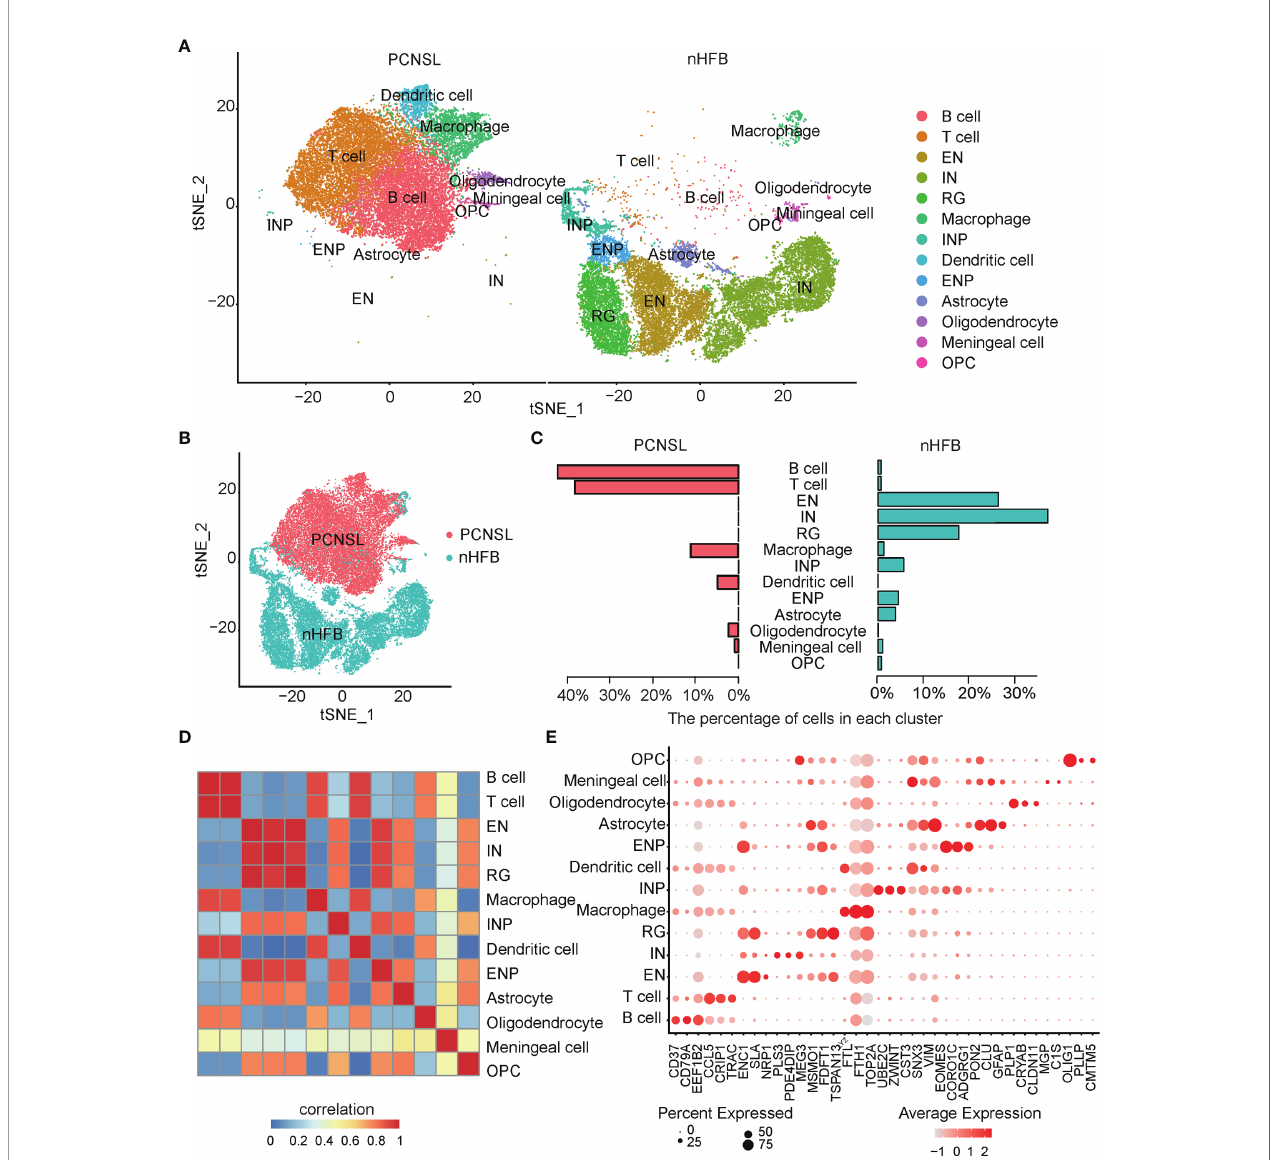
FIGURE 1 | Single-cell analysis of CNS scRNA-seq data sets. (A) The visualization results of cell subpopulations in PCNSL and normal CNS tissue samples. (B) The tSNE displays PCNSL and normal CNS cells: red indicates PCNSL cells, and green indicates normal cells. (C) The barplot represents the proportion of various cell subgroups in PCNSL and normal CNS tissue samples individually. (D) The heatmap describes the PCC values of the average expression values of the top 30 genes in each cluster. (E) The bubble chart shows that three marker genes are selected for each cell subgroup, and their expression in all cell subpopulations is